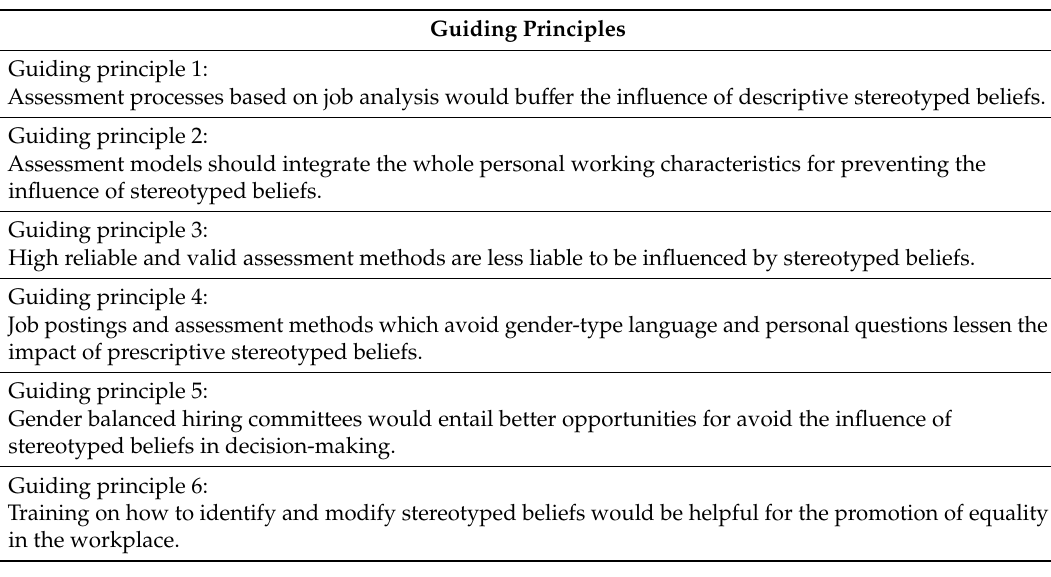
Table 8. Summary of guiding principles for the improvement of human resources managerial decisions regarding